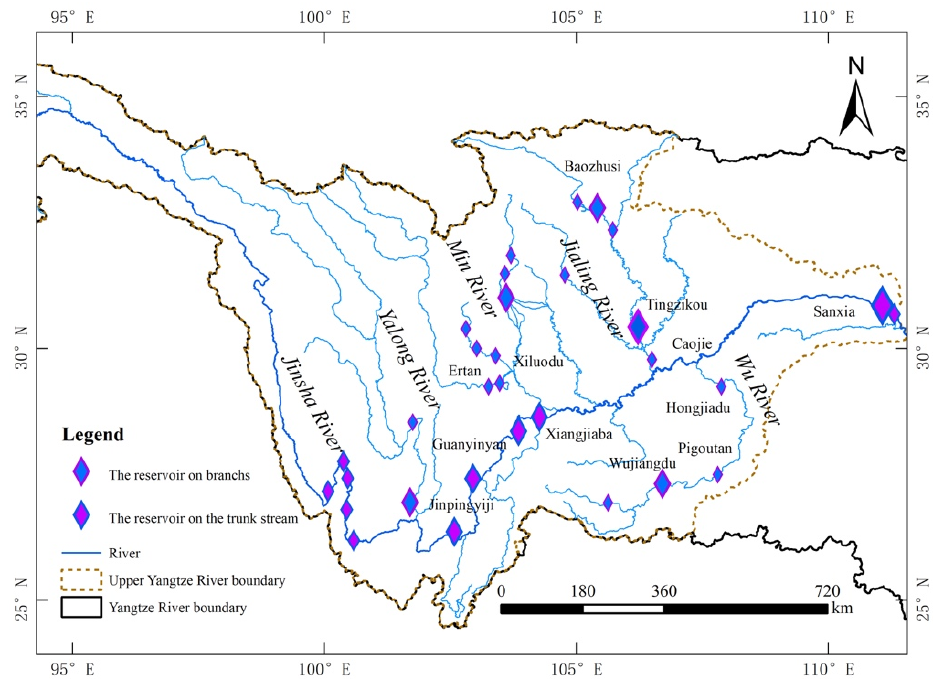
Figure 10. Schematic diagrams of reservoir construction in the upper reaches of the Yangtze River.